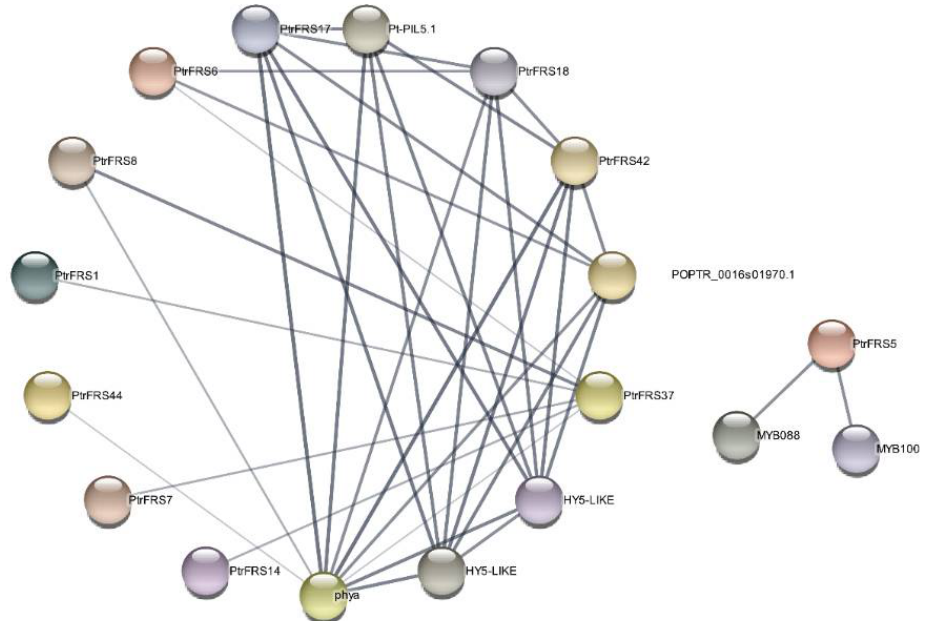
Figure 5. Predictive analysis of the PtrFREs regulatory